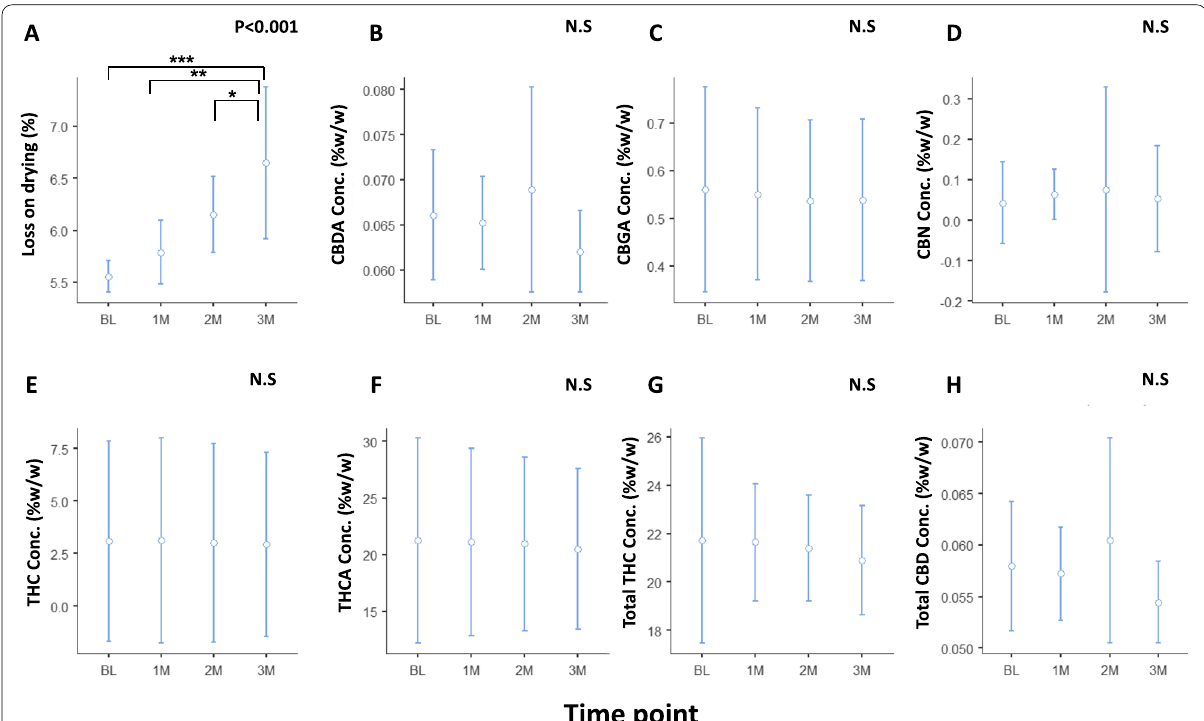
Fig. 2 Concentration of major phytocannabinoids in pre-packaged ground Cannabis inflorescence stored at 5°C. The middle circle represents the mean value of several duplicates and the upper and lower lines represent the upper and lower 95% confidence interval values. BL, baseline; M, month; CBDA, cannabidiol acid; THC, (-)-∆ 9 -trans- tetrahydrocannabinol; THCA, (-)-∆ 9 -trans- tetrahydrocannabinol acid; CBGA, cannabigerolic acid; CBN, cannabinol; “Total” represents the sum of the acid and neutral components. Statistically significant differences between times of storage were calculated by one-way ANOVA, utilizing Fisher’s exact test analyses (whenever significant, stated as the p value and when not significant stated as N.S.), followed by a Tukey post hoc multiple comparison test (*, p <0.05; **, p <0.01; ***, p